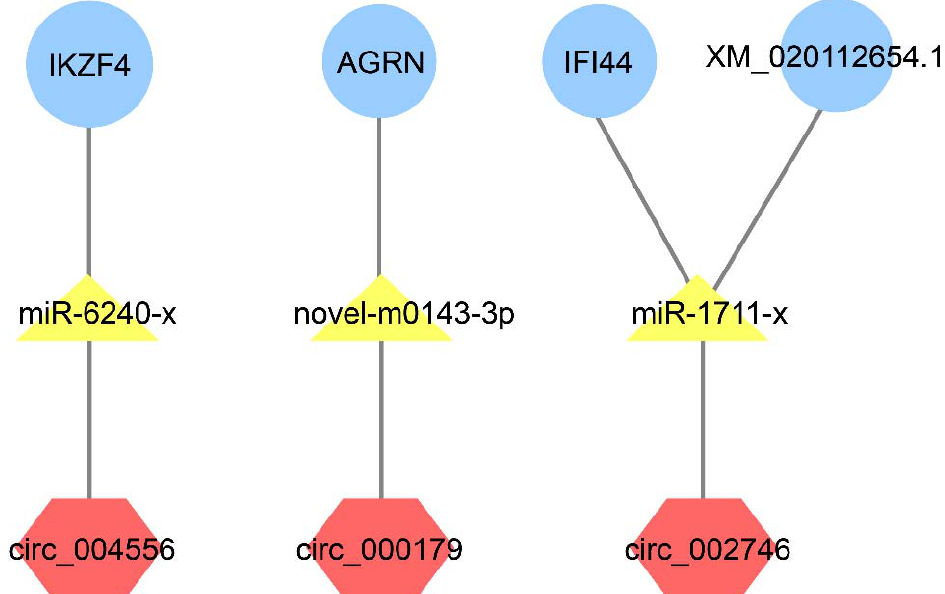
Figure 7. The predicted differentially expressed circRNA/miRNA/mRNA triplets. The yellow triangle nodes indicate the differentially expressed miRNAs (DEmiRs); the red hexagon nodes indicate the differentially expressed circRNAs (DEcircRs) that paired to the DEmiRs; the blue round nodes indicate the differentially expressed mRNAs (DEmRs) that paired to the DEmiRs.